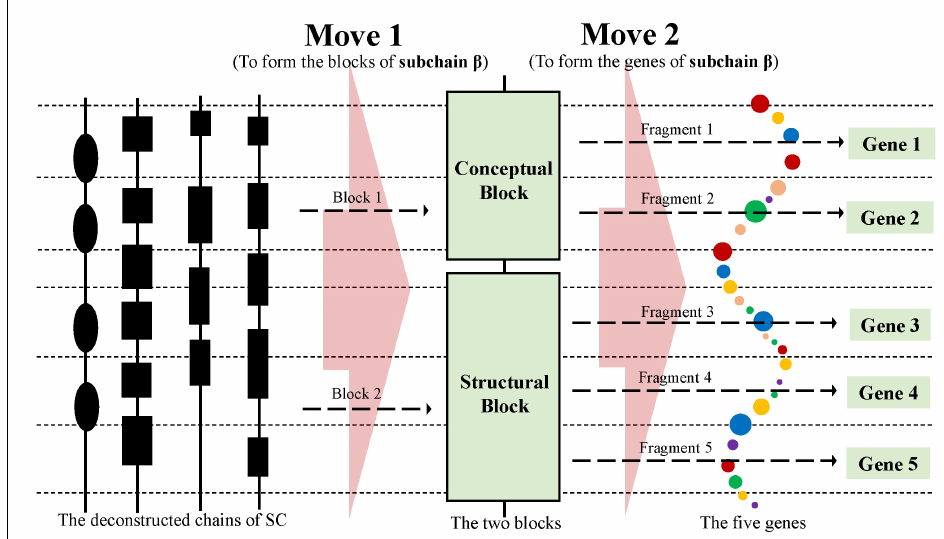
Figure 9. The logic expression from the reconstructed chains to the DNA Subchain β .